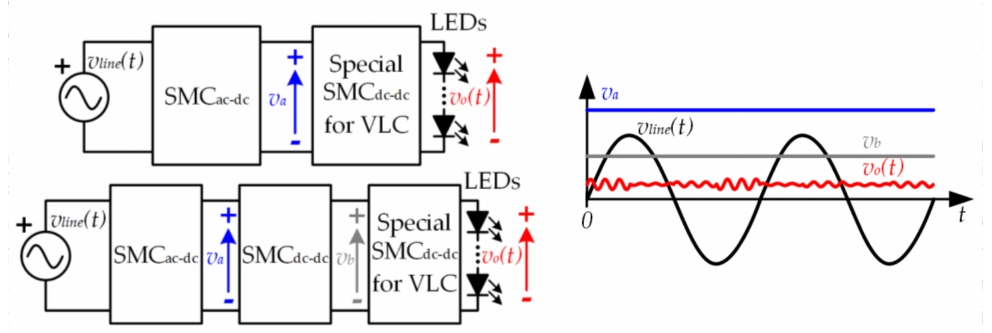
Figure 5. Modification of the existing SSL infrastructure to incorporate VLC while keeping high power